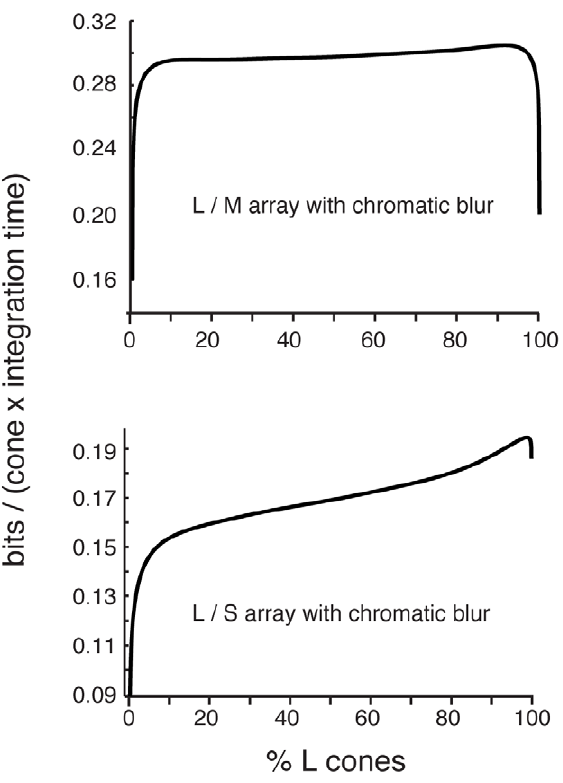
Figure 11. Optimal mosaic using photon noise binned calculation of single cone information (see text). Results are very similar to those in Fig. 5, using a Gaussian channel approximation. (Top) Information represented by a mixed LM array as a function of the percentage of L cones in the array. (Bottom) Information represented by a mixed LS